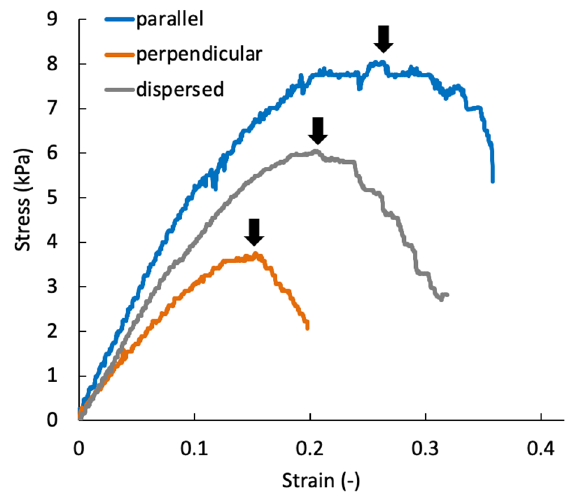
Figure 12. Cell number of the agarose gel-sheet constructs cultured for 21 days. Mean +/− S.D., n = 5. * indicates a significant difference in each value compared to day 0, p < 0.05.